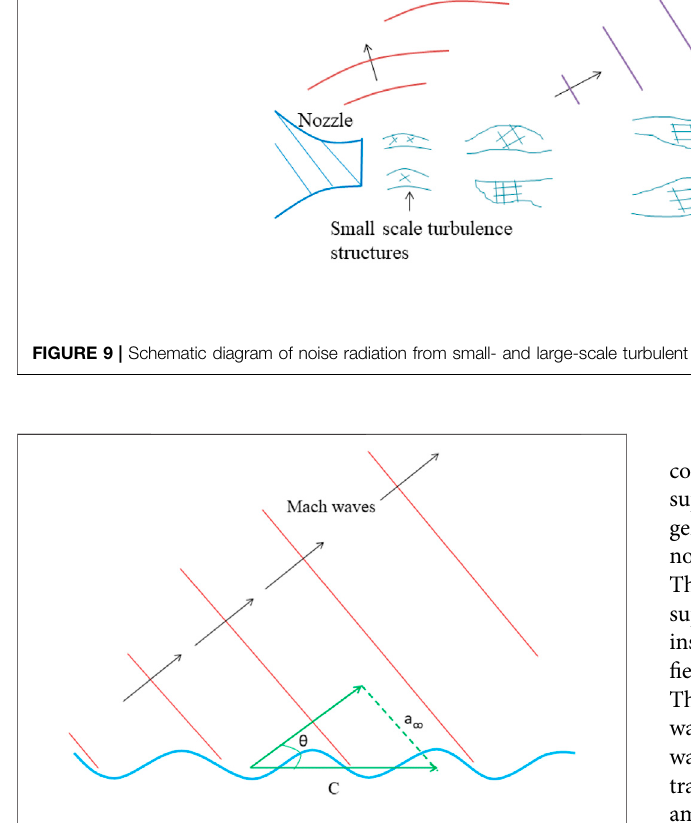
FIGURE 10 | Mach wave radiation from the wavy wall traveling at supersonic